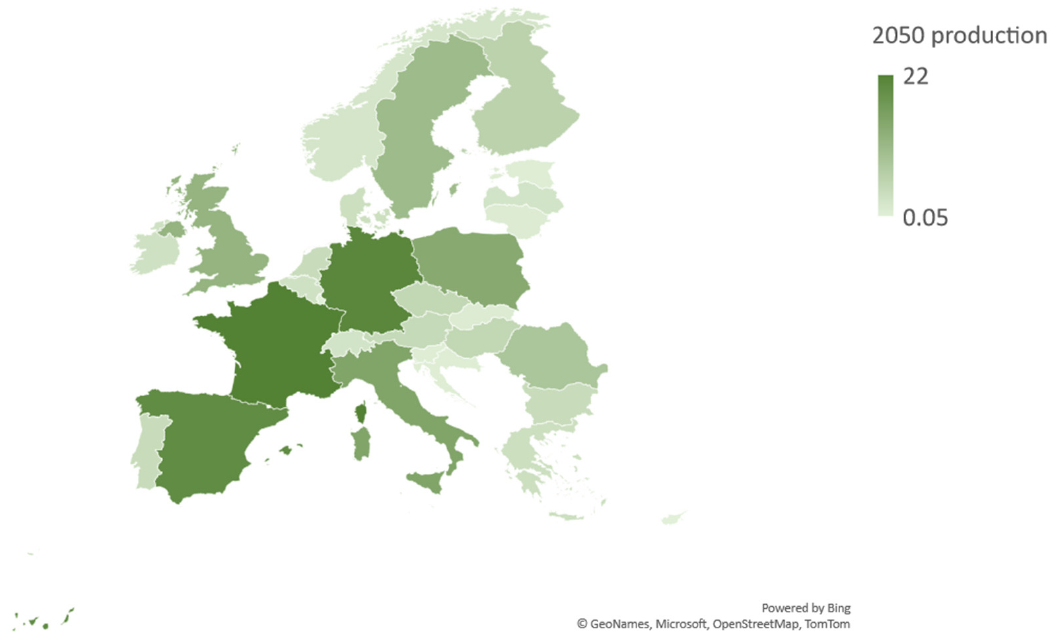
Figure 4. Estimated biomethane potential by 2030 per country in the EU27, the United Kingdom, Switzerland, and Norway. Data processed from [41].